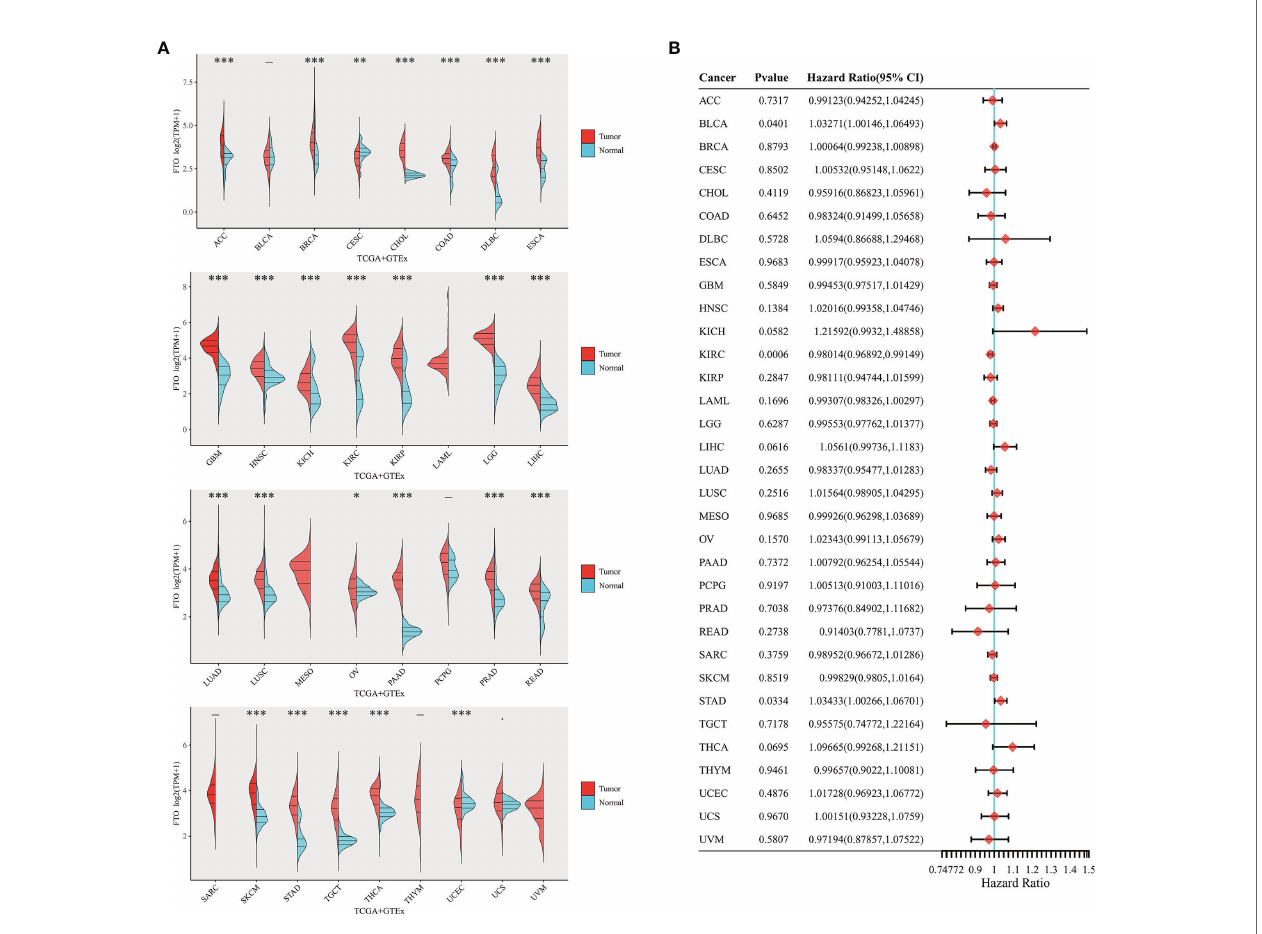
FIGURE 6 | Expression of FTO in the pan-cancer and prognosis. (A) Expression level of FTO in pan-cancer in TCGA+GTEx database. (B) Prognosis of FTO expression level in pan-cancer in TCGA database. The tumor abbreviations are annotated in Table S1 . *p < 0.05; **P < 0.01; ***P <